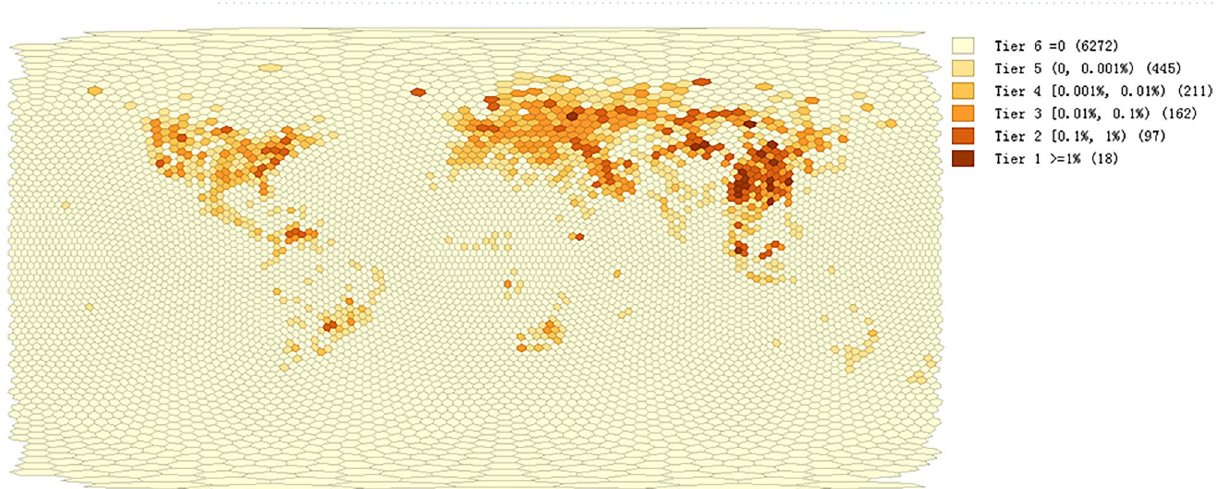
Figure 1. Global presence of Bitcoin mining activity. All mining locations detected (n = 6062) are mapped by their unique longitude and latitude coordinates. Details of each location are provided in Supplementary Table S2. The results are based on the monthly data from June 2018 to May 2019. The map is created by Geoda 1.18 (http:// geoda center. github. io/ downl oad. html).